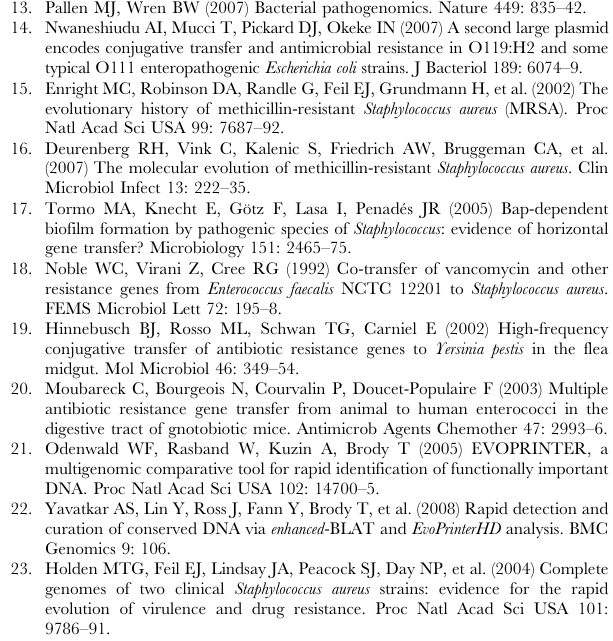
Table S1 MRSA252-RF122 uniquely shared chromosomal DNA sequence blocks. Figure S1 An EvoUnique profile identifies a putative nitric oxide reductase gene in the human S. aureus MRSA252 genome that is not present in the genomes of 16 other Staphylococci.